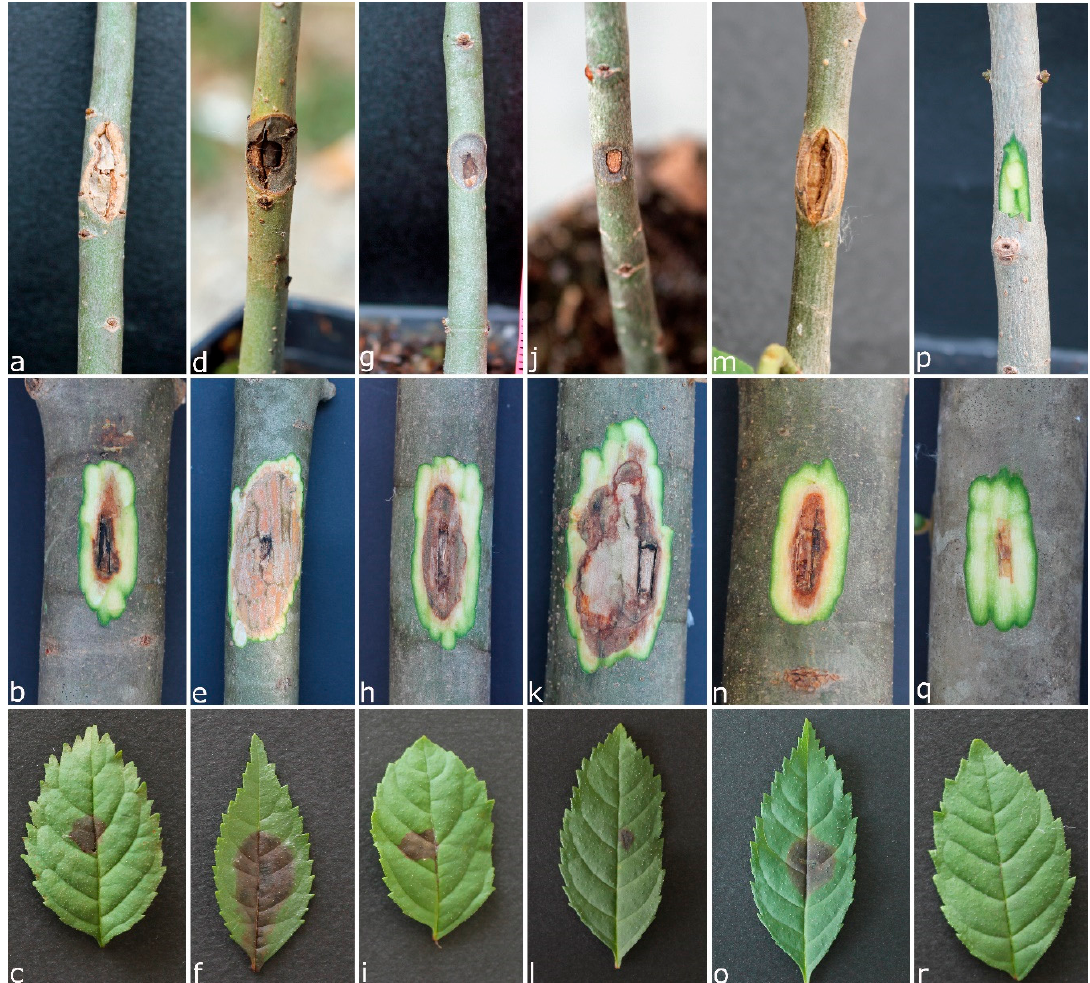
Figure 2. From top to bottom symptoms observed on seedlings, detached branches and leaves after inoculation with Diaporthe eres ( a – c ), Diplodia fraxini ( d – f ), Diplodia mutila ( g – i ), Diplodia subglobosa ( j – l ), Hymenoscyphus fraxineus ( m – o ). Controls ( p – r ). Table 4. Lesion sizes ± standard deviation caused by the five fungal species on European ash and number of positive re-isolations from seedlings (S), detached branches (B) and leaves (L). Mean Lesion Length (cm) Fungal Species